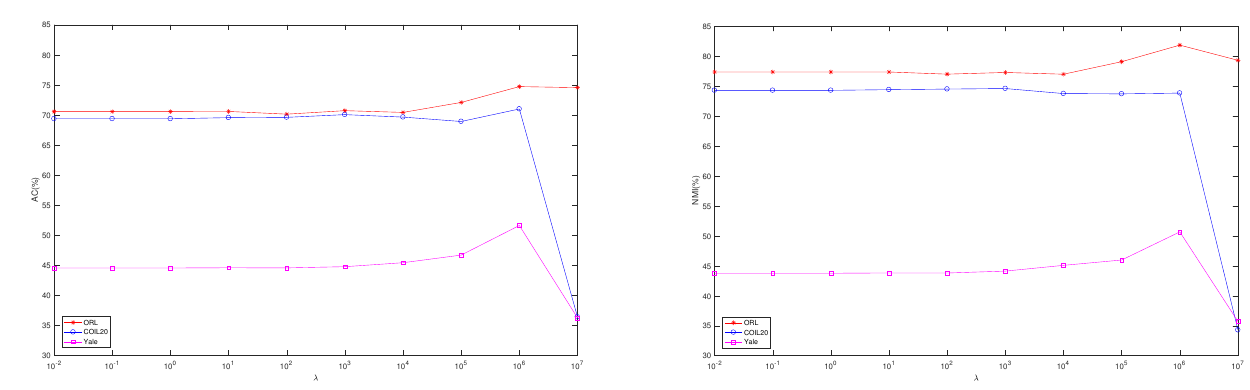
Figure 2. The clustering performance of DNTD method in term of AC and NMI with varied parameter λ on ORL, COIL20 and Yale